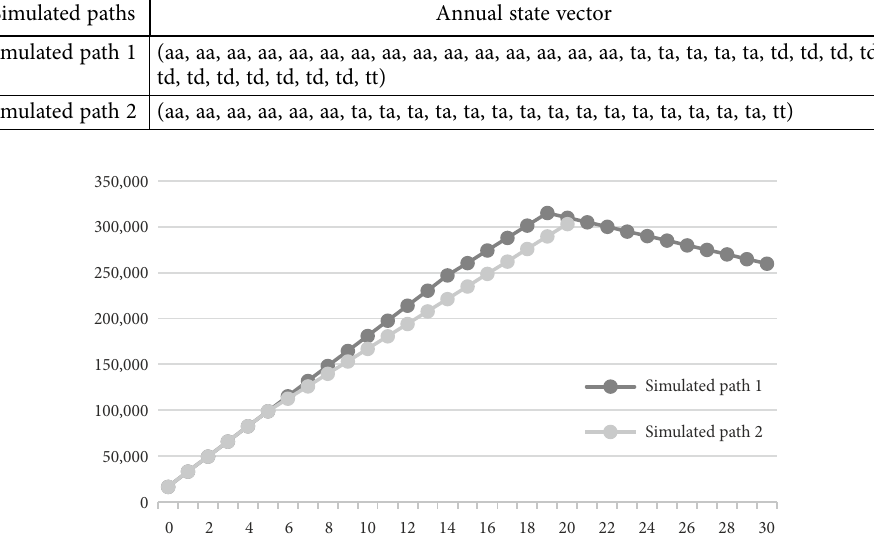
Table 9. Annual state vectors for household 2 of Profile 2 with RM (source: own elaboration) Simulated paths